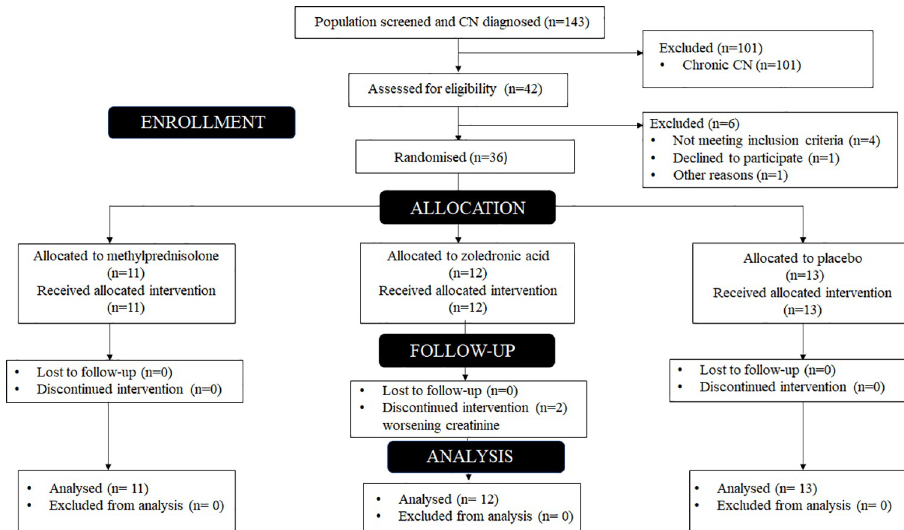
Fig 1. Randomisation protocol as per the CONSORT guidelines (CN- Charcot’s Neuroarthropathy).